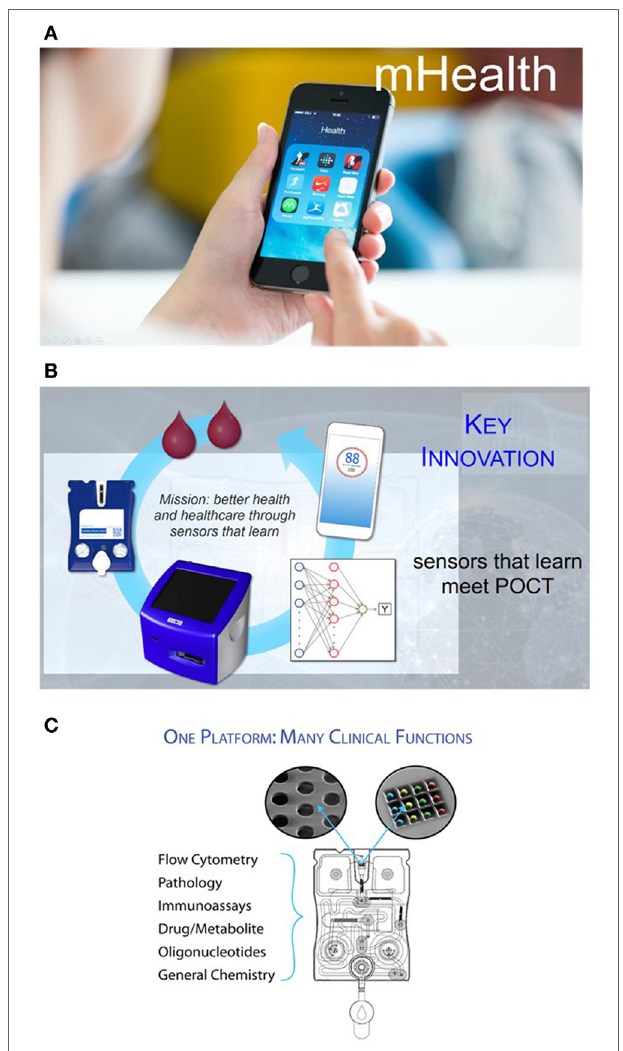
FigURe 1 | (A) Finding a way to provide patients and physicians the ability to cull biomarker information via diagnostic tests and then using the processing power and rich interface of smart phones opens the door to a more empowered patient and a more data savvy clinician. (B) The point-of-care (POC) programmable bio-nano-chip includes a universal analyzer with functional integrated mechanical/optical interfaces and flexible microchip architecture. An injection-molded, “credit-card”-sized cartridge encloses either a bead array or a membrane, where complex immunoassays or cellular analyses are performed, respectively. (C) Nanomaterials and microelectronics have been combined and adapted for the practical implementation of two classes of mini-sensors (membrane for cellular analyses and bead array for soluble target analyses) that read out with high-performance, yet affordable, imaging systems. These systems promise POC capabilities of tests traditionally completed by larger and more expensive systems confined in the lab, without sacrificing